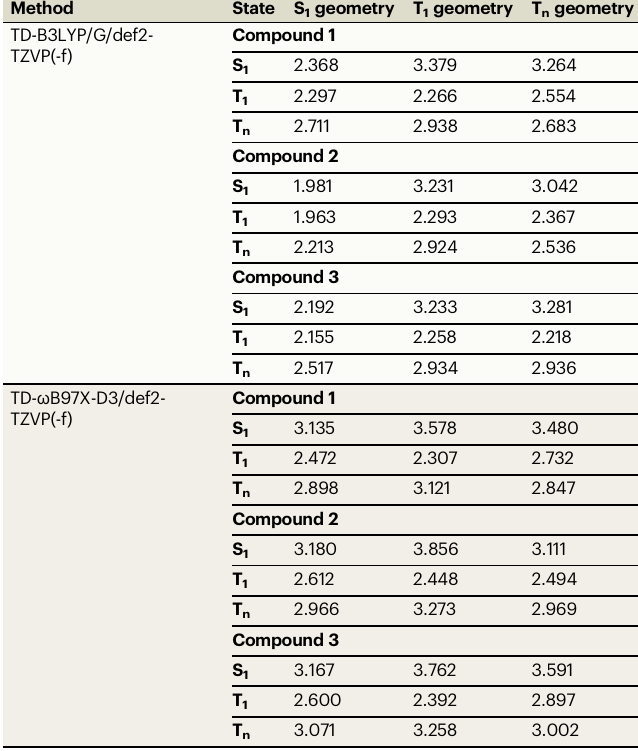
Table 2 | S 1 , T 1 and T n excitation energies (eV) of BPBF 2 com- pounds calculated at respectiveoptimized geometry ( n = 2 for compound 1 and 2, n = 3 for compound 3) Method